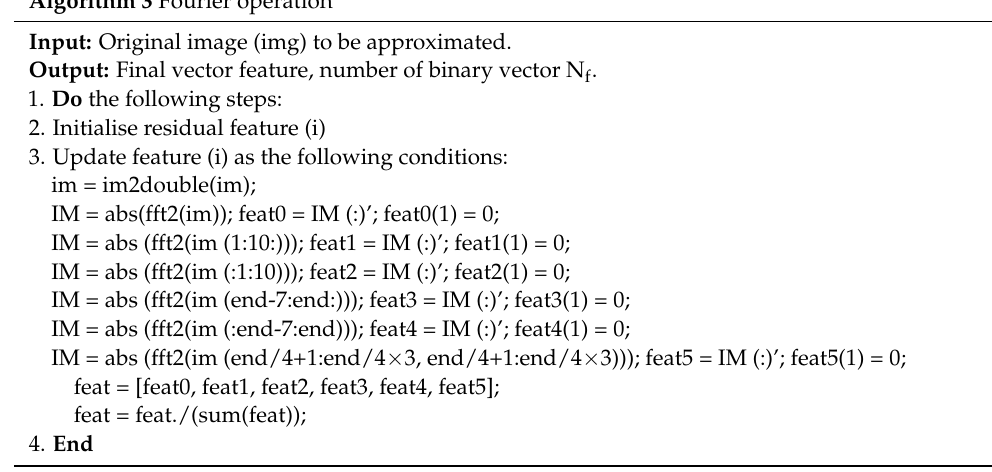
Algorithm 3 Fourier